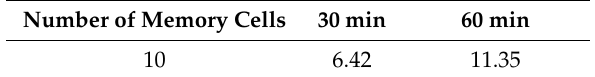
Table 3. RMSE values in mg / dL split70% for training and 30% for